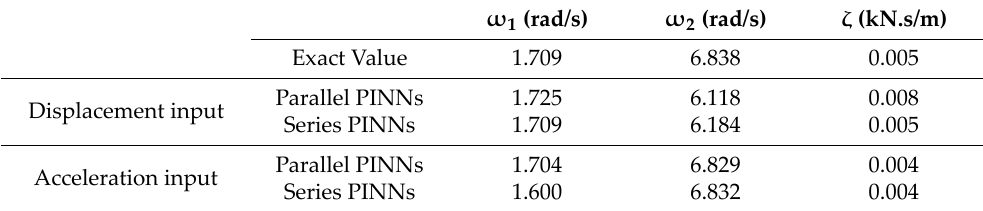
Figure 29. The loss function of the parallel PINNs with displacement input. Table 4. The modal properties of the beam subjected to moving loads estimated by the